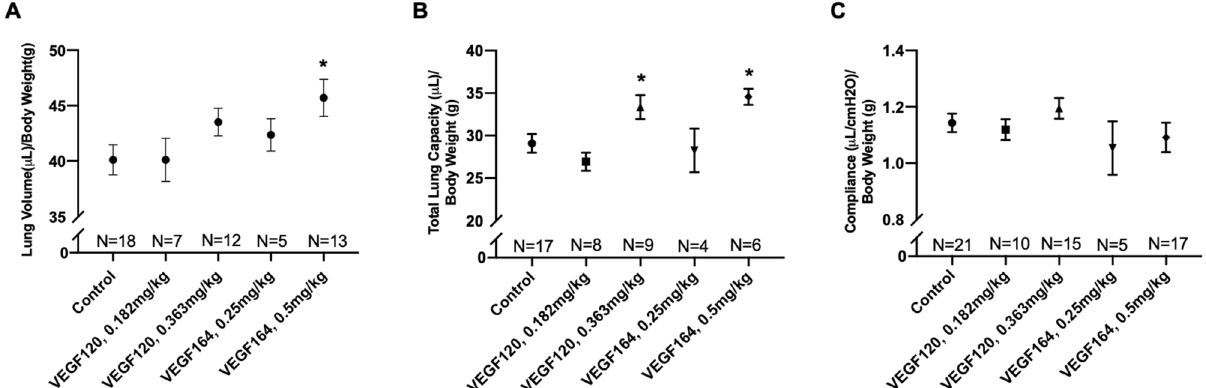
Figure 1. Lung volume and pulmonary function testing. Both VEGF164 and VEGF120 increased lung volume, as measured by the water displacement method ( A ), and total lung capacity on pulmonary function testing ( B ). However, only the higher dose of VEGF164 induced a significant increase in lung volume, while both the higher dose of VEGF164 and the the equimolar dose of VEGF120 significantly increased total lung capacity. Compliance was not significantly different between VEGF-treated mice and controls ( C ). Statistical analysis of lung volume, total lung capacity, and compliance was performed by ANOVA with Holm-Sidak correction for multiple comparisons. Results are expressed as mean ± SE. *P < 0.05. Mouse cohorts of pneumonectomies were performed in three independent repeats. On any given operative day, a control group of mice was included.